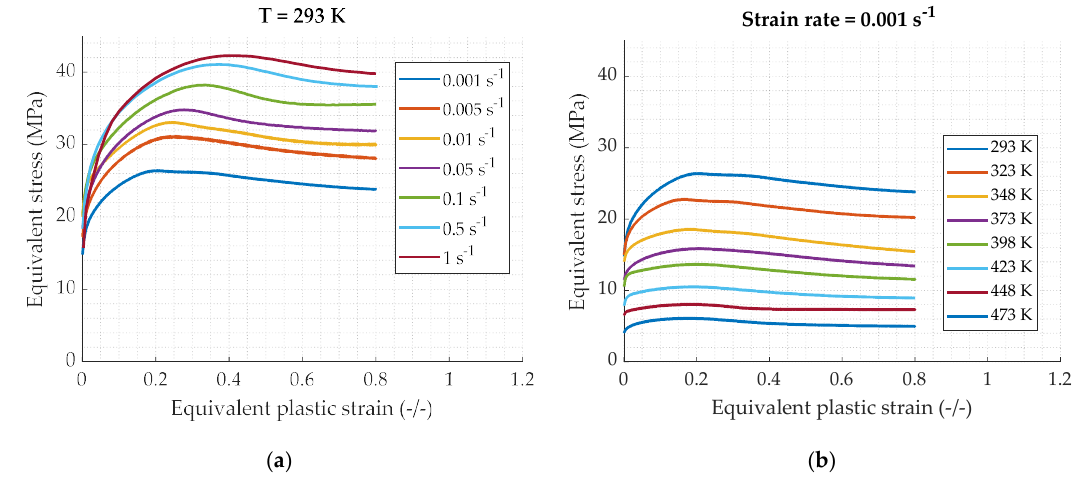
Figure 5. True plastic strain–true stress curves for quasi-static compression loading: ( a ) strain rate